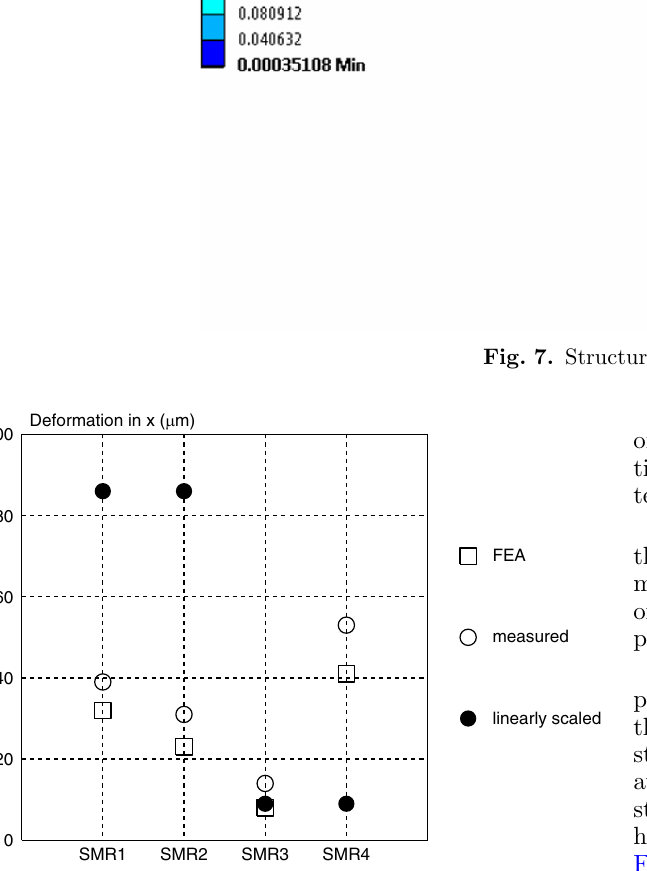
Fig. 8. Comparison of x